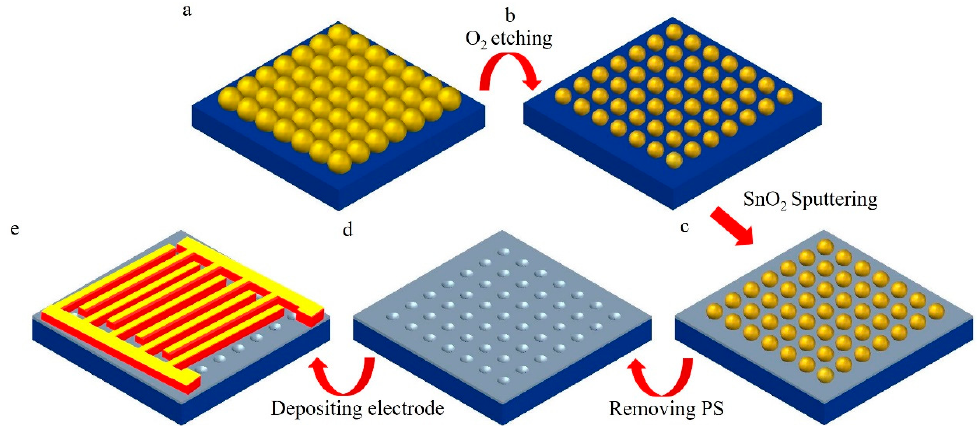
Figure 1. The schematics of the procedure for fabricating the SnO 2 nanostructure. ( a ) A monolayer of polystyrene nanosphere was fabricated on Si substrate by self-assembly. ( b ) The nanospheres were etching by O 2 . ( c )The SnO 2 was sputtering. ( d ) The nanospheres were removed. ( e ) The fork-shaped electrodes were prepared by electron-beam evaporation. The humidity environments were provided by using self-made air-tight glass chambers containing a series of standard aqueous salt solutions (LiCl, Mg(NO 3 ) 2 , MgCl 2 , NaCl, KCl and KNO 3 ), with the RH being about 11%, 33%, 54%, 75%, 84%, and 96%, respectively. The electrical resistance